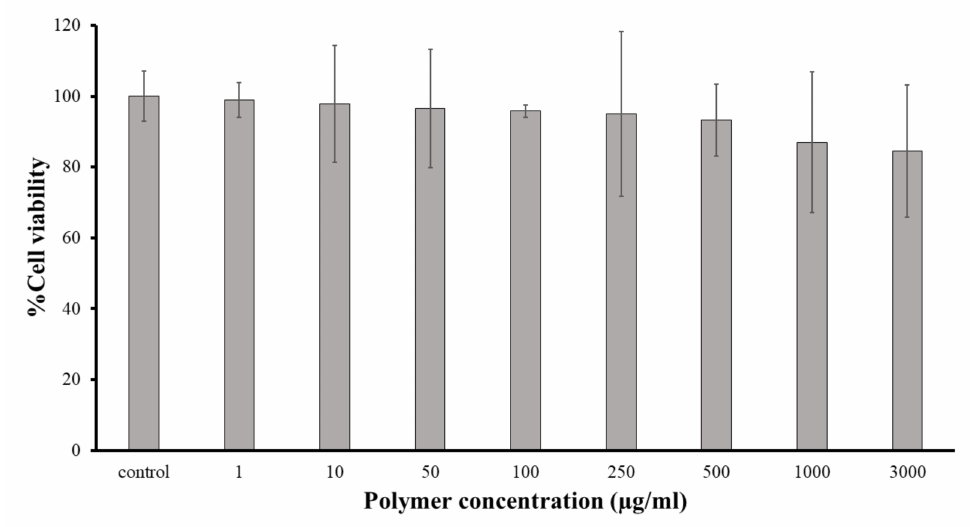
Figure 4. Percentage cell viability of the synthesized PVPAA on HSF